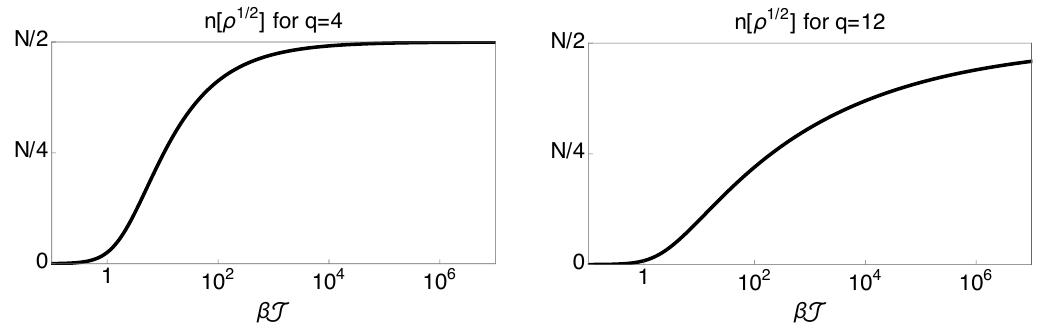
Figure 7 . Plots of the average size of (cid:26) 1 = 2 / exp ( (cid:0) (cid:12)H= 2) for di(cid:11)erent q , given by eq. (5.2).